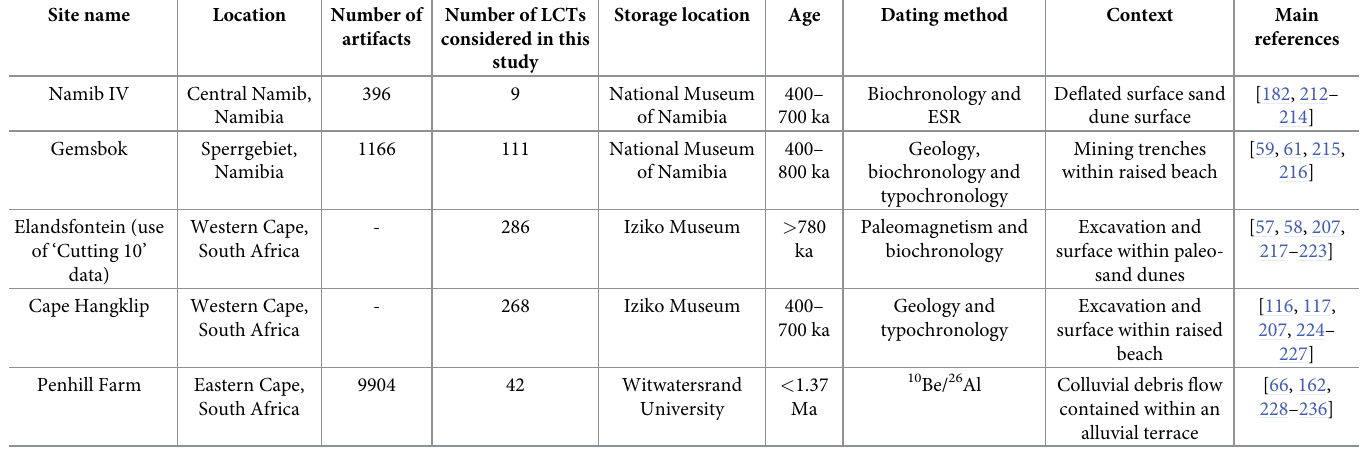
Table 3. Details and bibliography used for the lithic collections from Middle Pleistocene transition Earlier Stone Age sites from the southern African coastal plain: Namib IV, Gemsbok, Elandsfontein, Cape Hangklip and Penhill Farm. Site